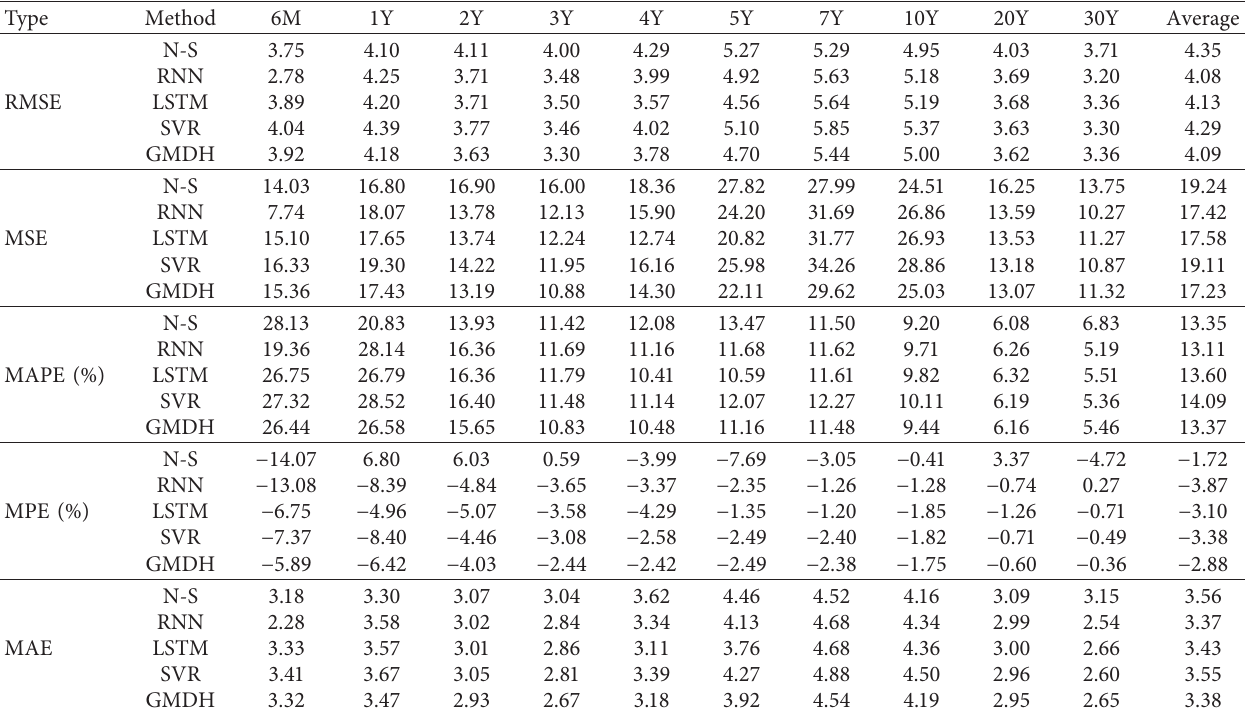
Table 7: Error statistics of each method for all maturities for test dataset 2 with the subperiod 1 training set (case 2).